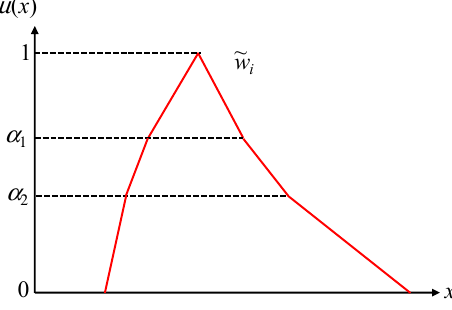
Figure 3. A fuzzy priority estimated using PLFGM.